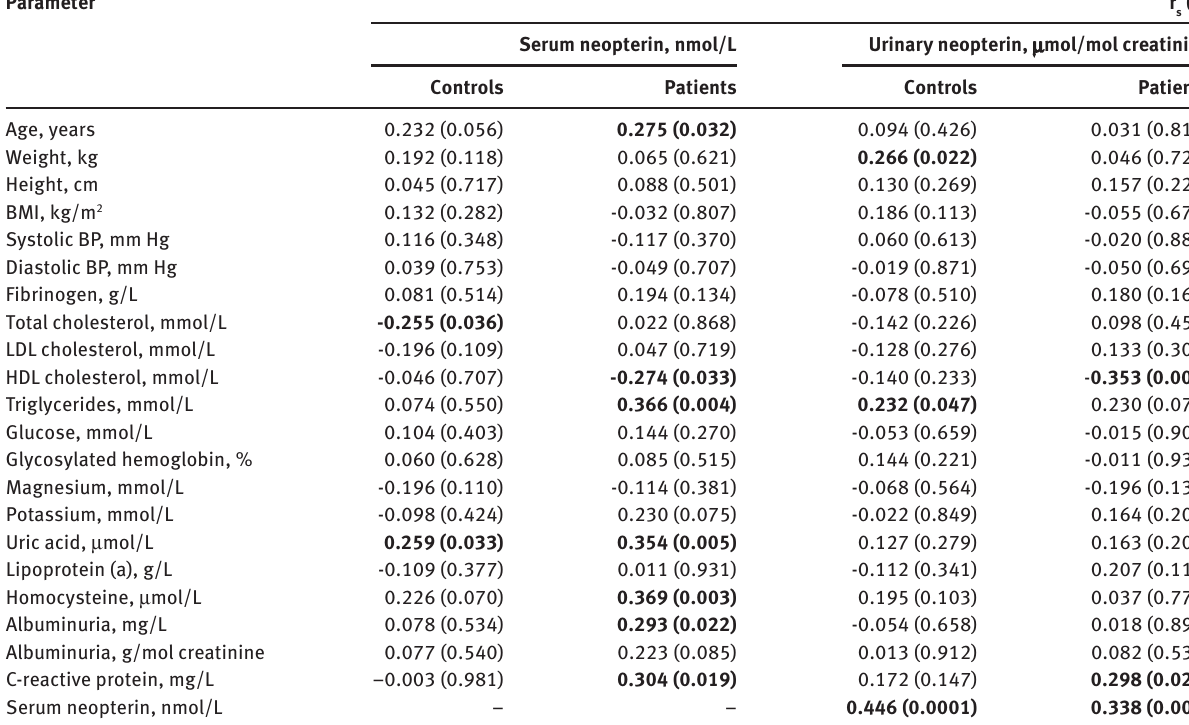
Table 5 Correlation of neopterin concentration with clinical and laboratory parameters.